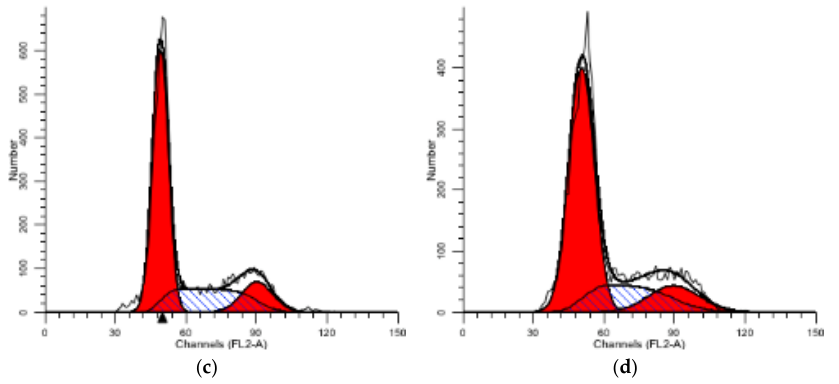
Figure 4. Compound 1 effect on cell cycle of HepG2 cells: ( a ) control group; ( b ) 1 μ M; ( c ) 3 μ M; and ( d ) 12 μ M.